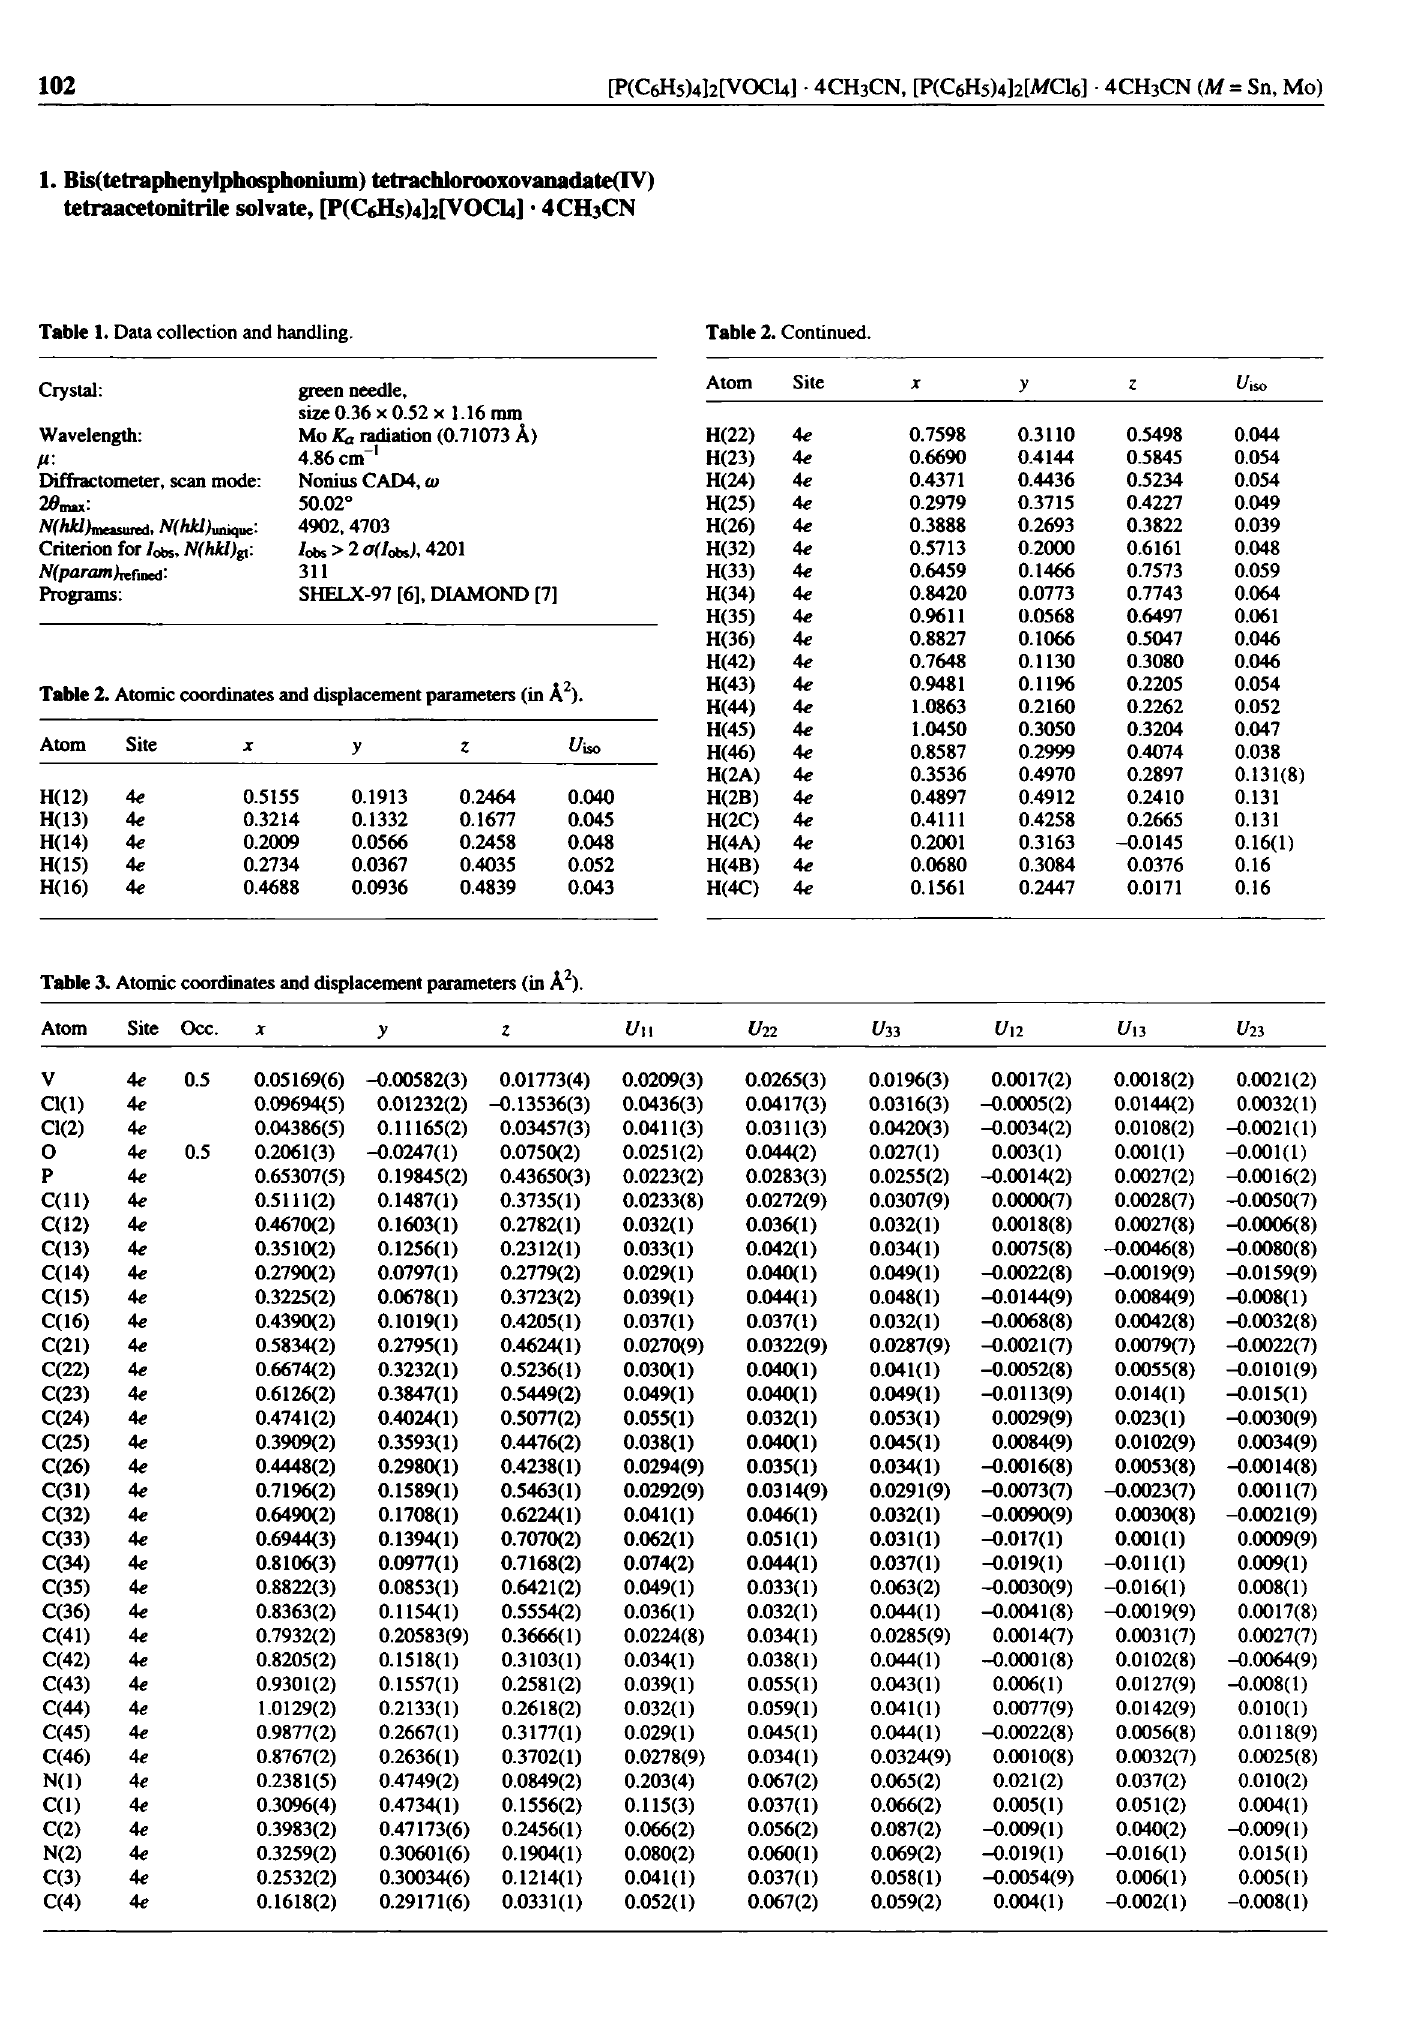
Table 2. Atomic coordinates and displacement parameters (in Â 2 ).